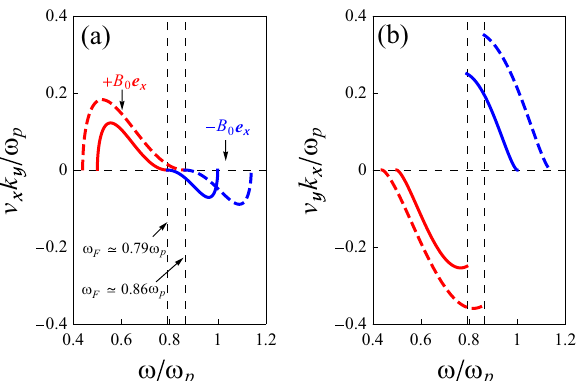
Figure 4. Group (energy) velocity curves of SMPs at a flat magnetized electron gas-vacuum interface, as obtained from Eqs. (10) and (11), when k x and k y are positive. ( a ) Variation of v x (i.e., v gx or v ex ), when k y is constant. ( b ) Variation of v y (i.e., v gy or v ey ), when k x is constant. Here the different curves refer to ω c 0.7 ω p (dashed lines). (solid lines), and ω c =